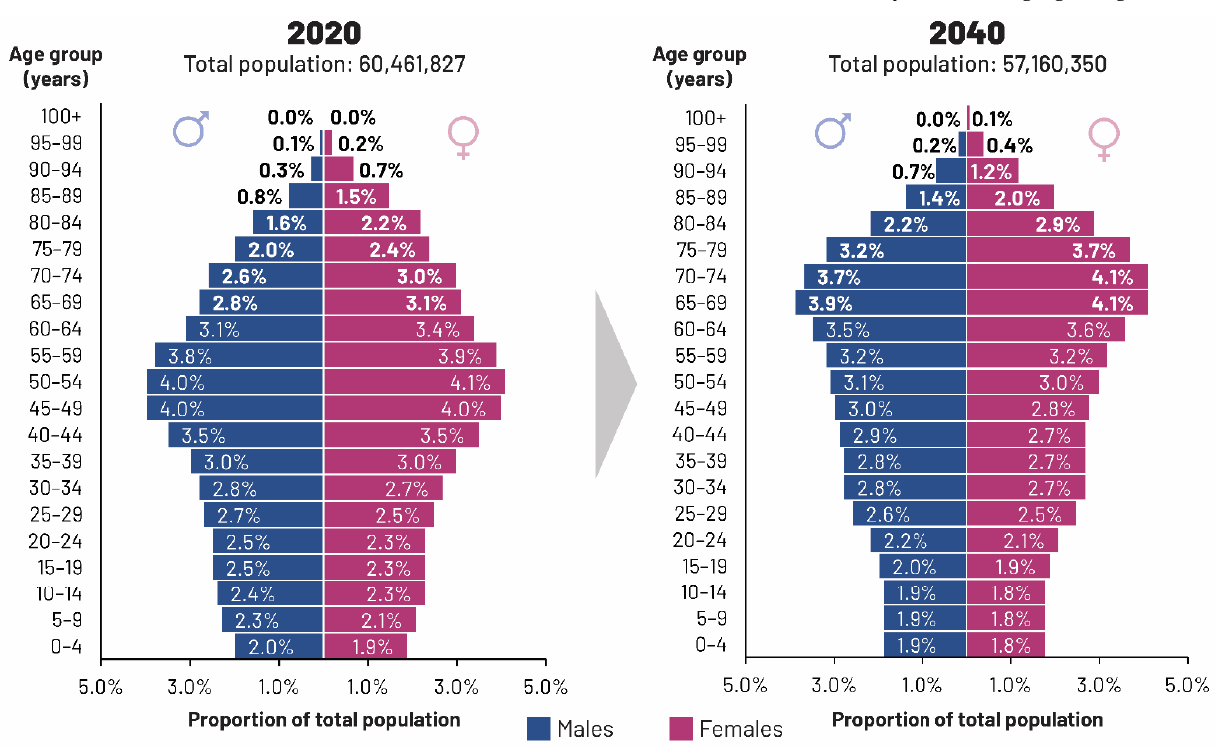
Figure 2. Italian population pyramid, 2020 vs. 2040 estimates. Source: PopulationPyramid.net. Piramide della Popolazione Mondiale dal 1950 al 2100 (World Population Pyramid from 1950 to 2100). Available online: https://www.populationpyramid.net/ (accessed on 19 April 2021) [33] under the terms of the Creative Commons Attribution License (https://creativecommons.org/licenses/by/3.0/igo/, accessed on 10 October 2021). Copyright © 2019 PopulationPyramid.net.